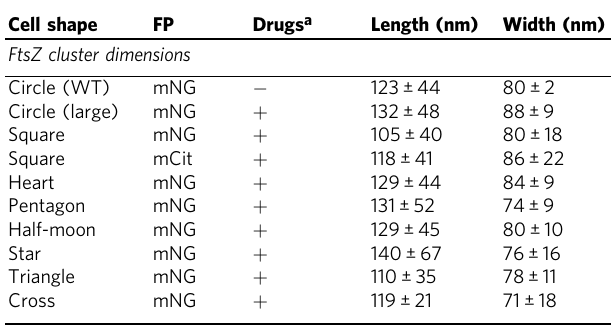
Table 1 Summary of FtsZ cluster dimensions at midcell in various cell shapes Cell